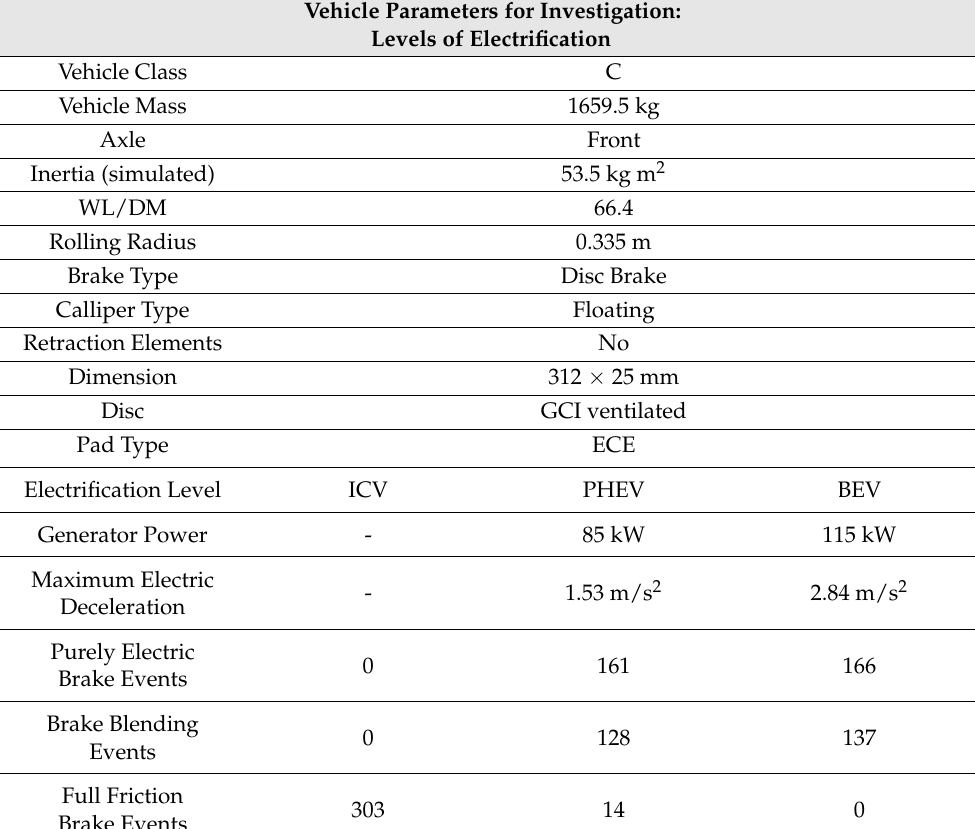
Table 4. Vehicle parameters for investigation: levels of electrification. Vehicle Parameters for